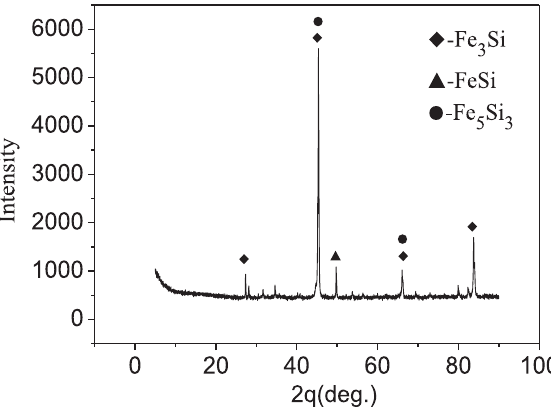
Figure 11: XRD patterns on the surface of the deposited layer.